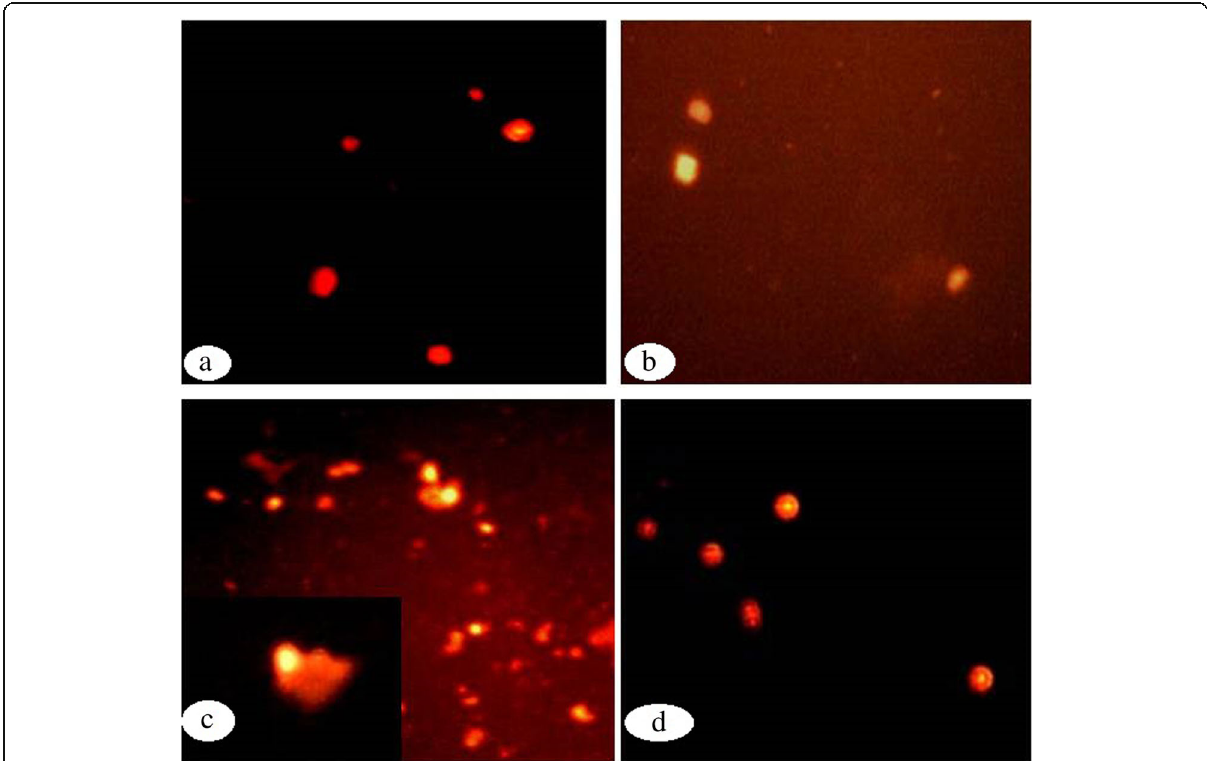
Fig. 2 Photomicrographs of comet assay showing ( a , b ) typical nuclei of undamaged testicular cells of control and PSO groups. c DNA damage observed as comets that were seen in the Al 2 O 3 -NP group and d (PSO + Al 2 O 3 -NP) group